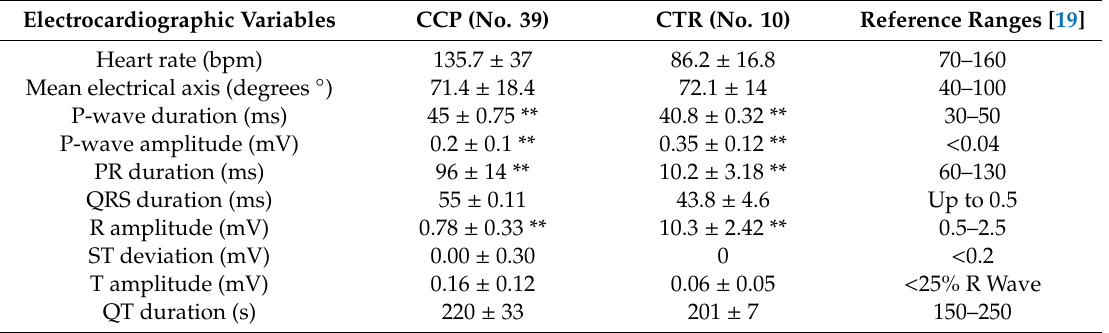
Table 3. Mean and standard deviation of electrocardiographic findings analyzed for both groups, and the results of the statistical